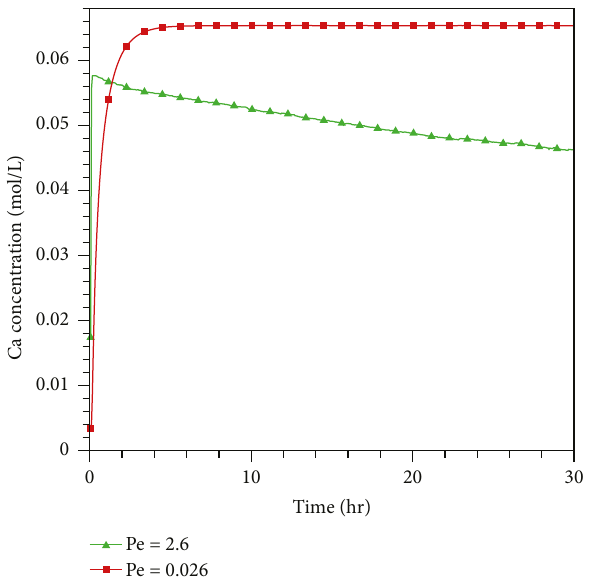
Figure 27: E ffl uent Ca concentrations versus time at two di ff erent Pe